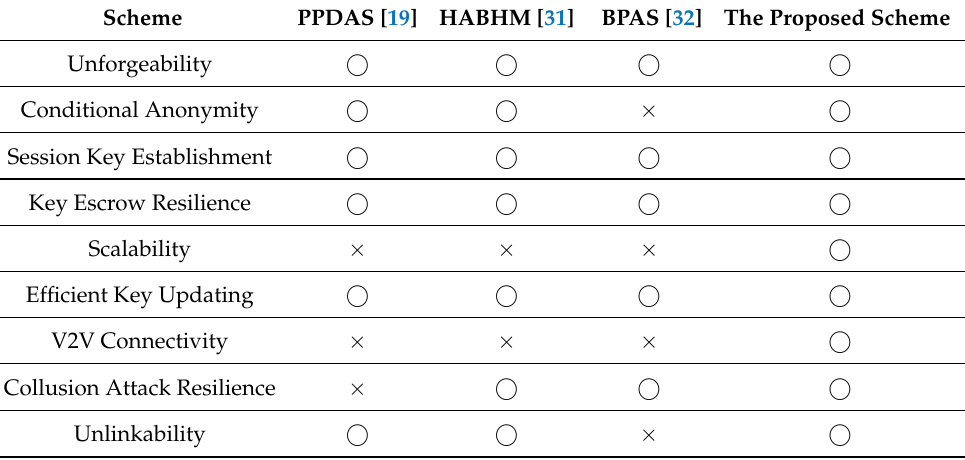
Table 2. Comparison results on security